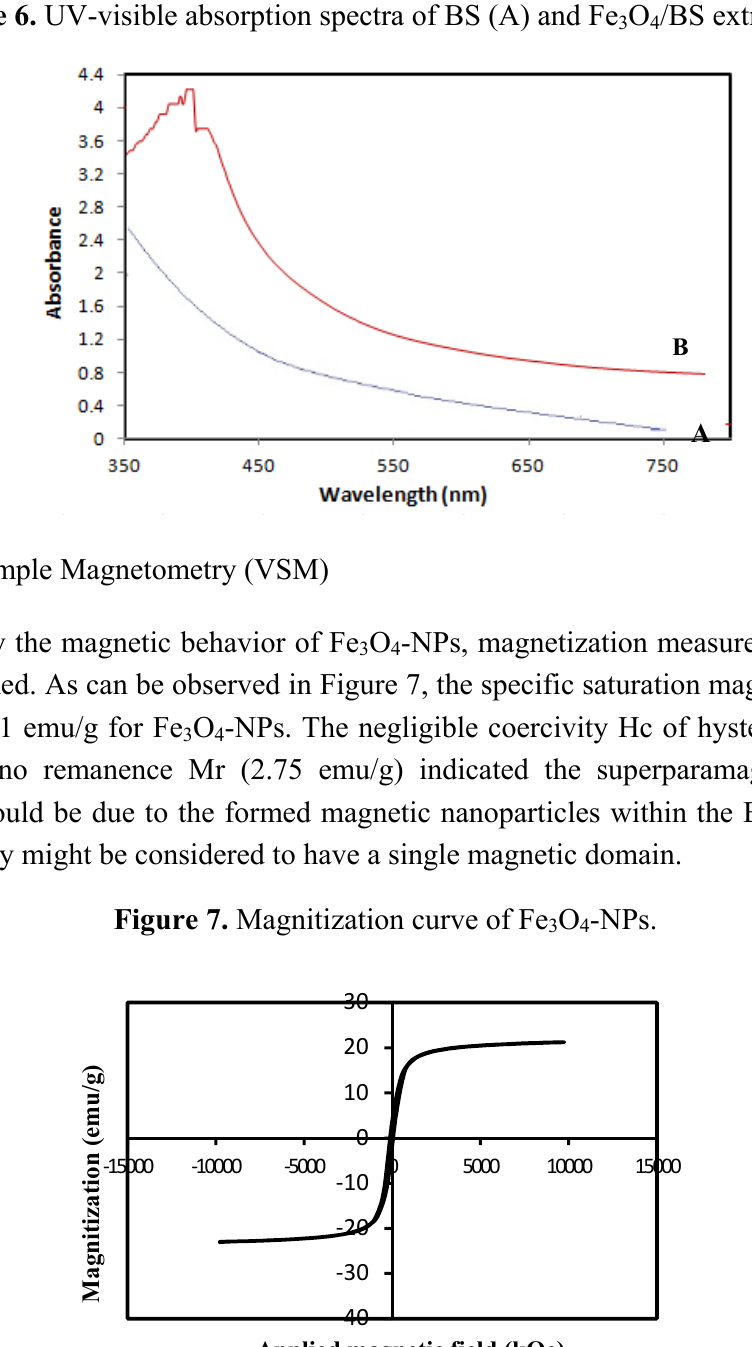
Figure 6. UV-visible absorption spectra of BS (A) and Fe